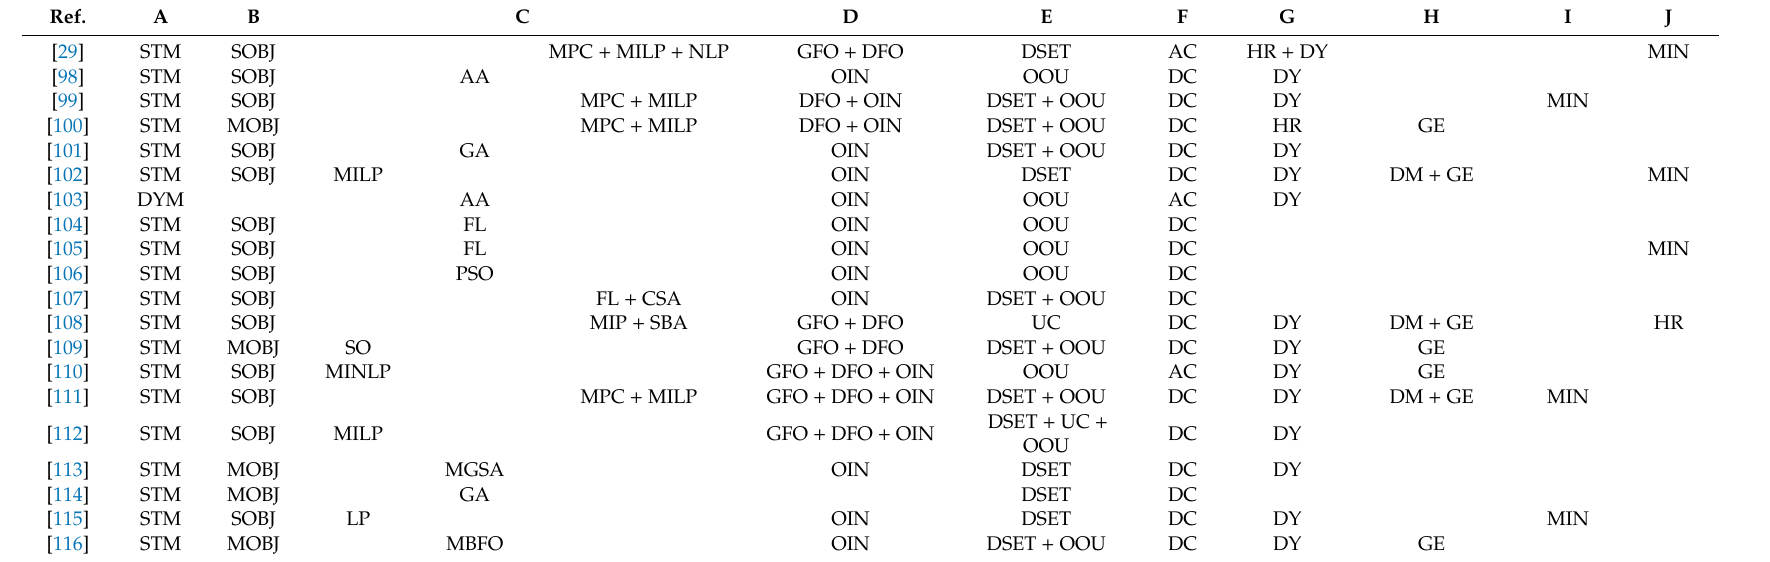
Table A6. Papers published in 2014.